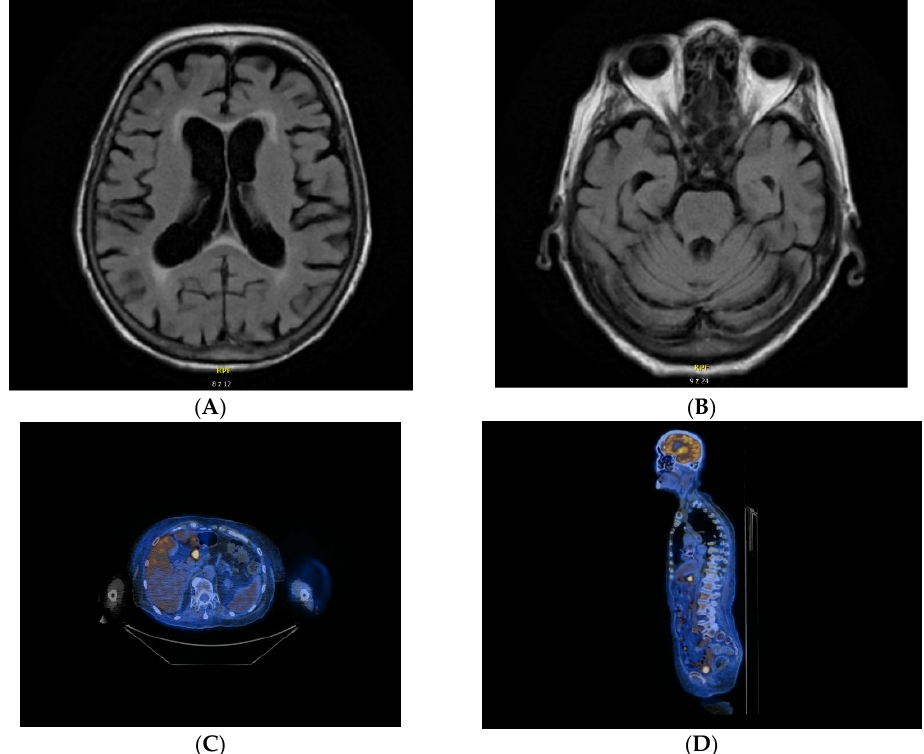
Figure 1. MRI and PET/CT results of a patient with cerebellar degeneration. ( A , B ) nonspecific vascular demyelination detected on MRI. ( C , D ) metabolically active area in the pylorus and in the locoregional lymph nodes detected on [18F]FDG PET/CT.